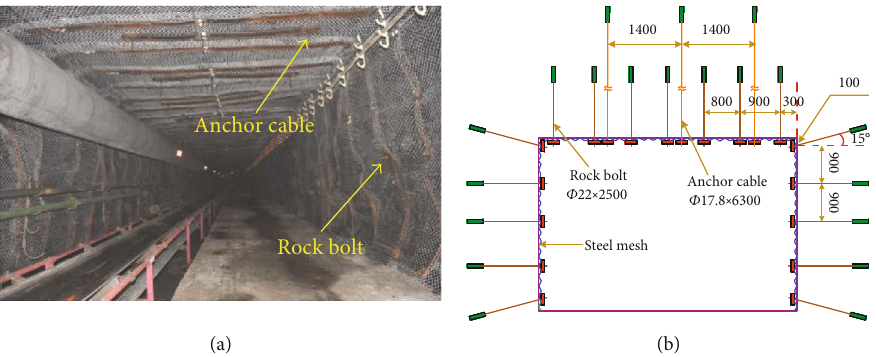
Figure 3: Initial roadway support scheme. (a) Field support picture. (b) Support spacing